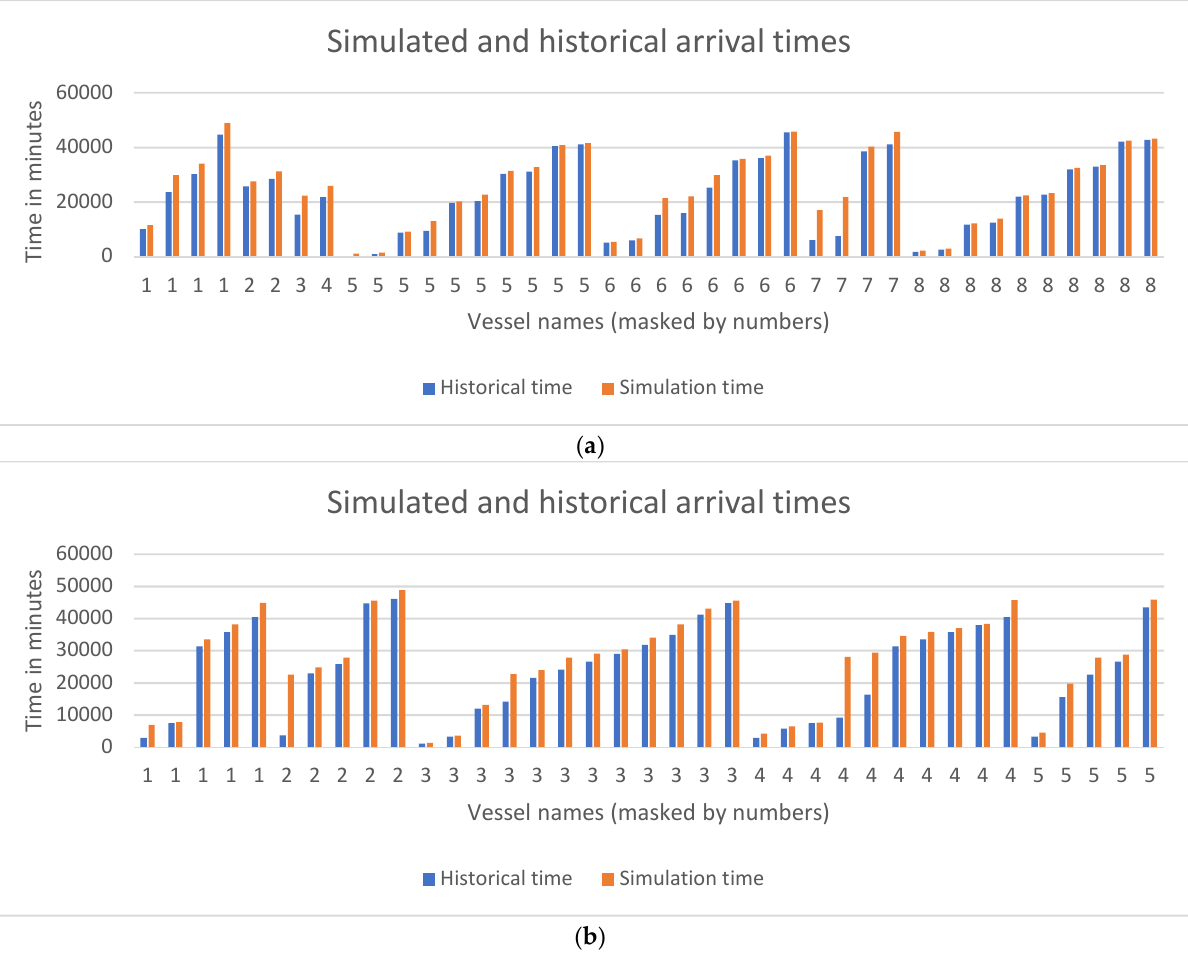
Figure 8. ( a ) Historical and simulated arrival times comparison: Set 1. ( b ) Historical and simulated arrival times comparison: Set 2. Table 5. Range of